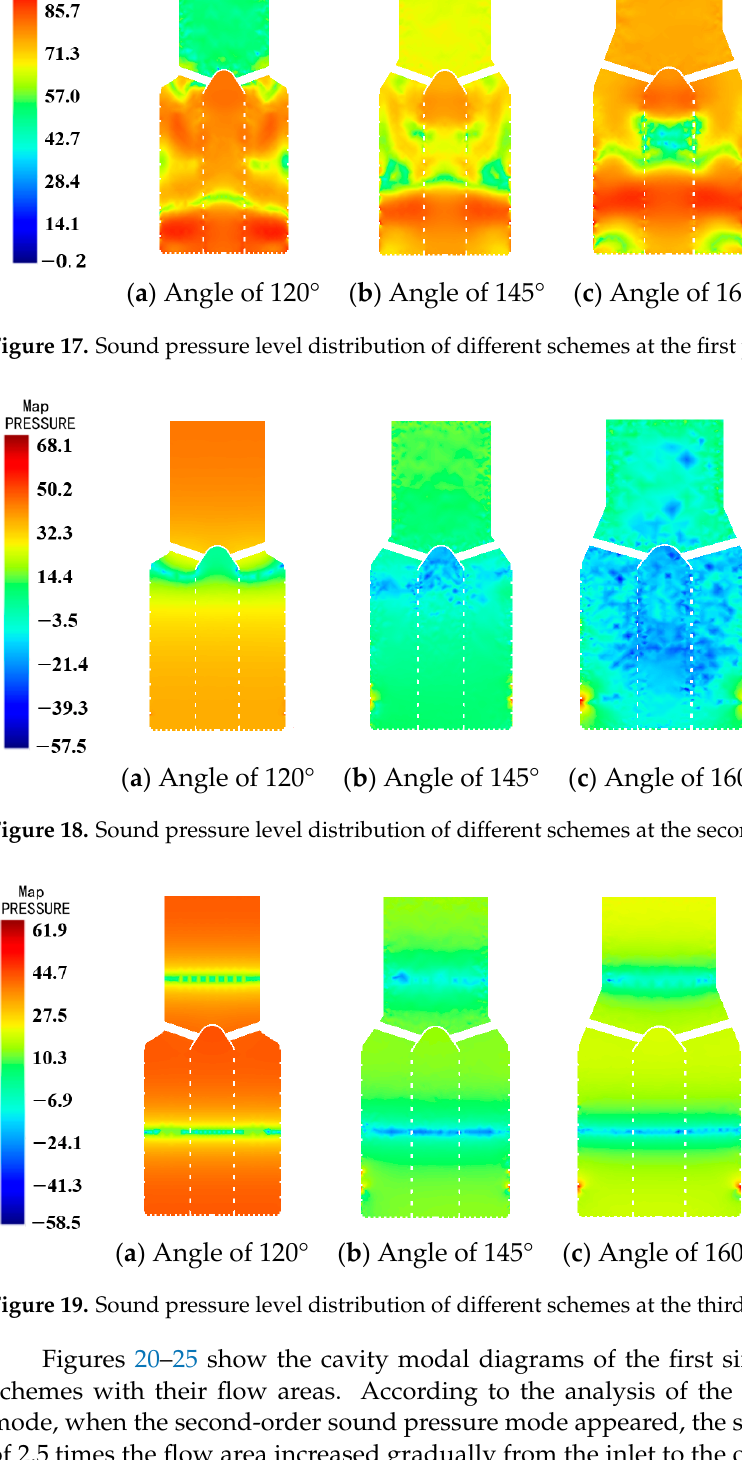
Table 3. Modal natural frequencies of mufflers with different flow areas. Flow Area of 2.5 Order